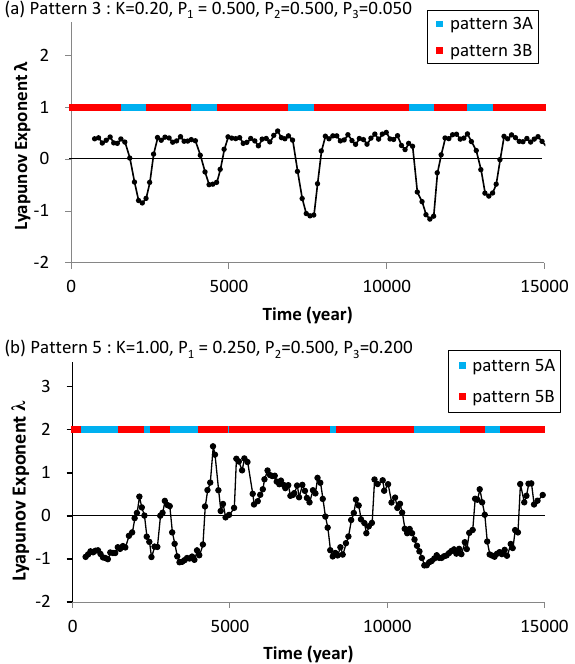
Figure 17. Examples of the variation of Lyapunov exponents λ for patterns 3 and 5. λ(t) is plotted at the ends of time windows where λ(t) is calculated. The blue and red bars indicate the time periods of patterns A and B, respectively.